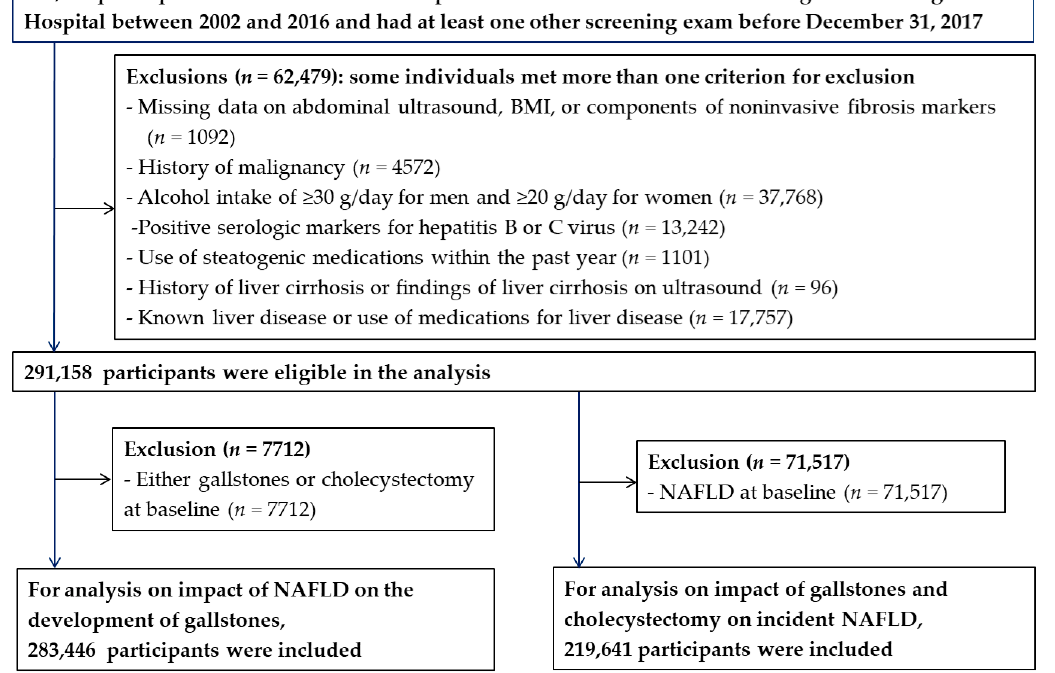
Figure 1. Flow diagram for the selection of study subjects.